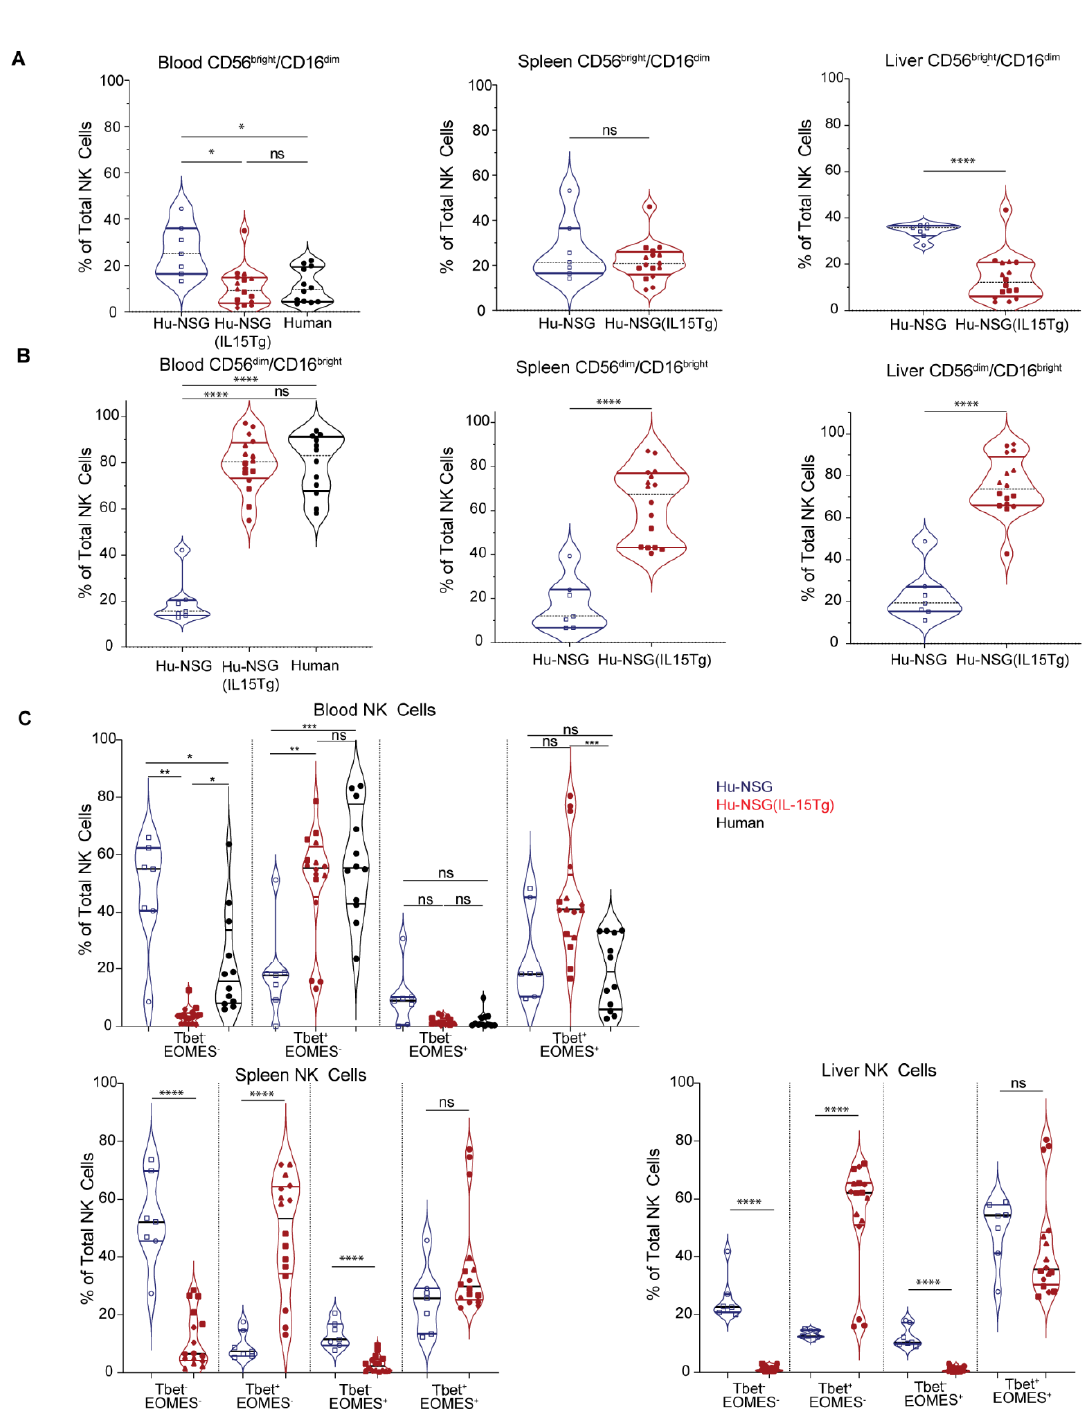
Figure 4. Phenotypically mature human NK cells are elevated in Hu-NSG-Tg(IL-15) mouse tissue. ( A ) Frequency of CD56 bright CD16 dim of NK cells in blood, liver, and spleens of Hu-NSG mice ( n = 7, 2 unrelated donors), Hu-NSG-Tg(IL-15) mice ( n = 16, 4 unrelated donors) 6 months post CD34 + HSC transplant, and human donors ( n = 12). ( B ) Frequency of CD56 dim CD16 bright subset in blood, livers, and spleens of Hu-NSG and Hu-NSG-Tg(IL-15) mice 6 months post CD34 + HSC transplant. ( C ) Tbet and EOMES expression of NK cells in blood, liver, and spleens of Hu-NSG, Hu-NSG-Tg(IL-15) mice 6 months post CD34 + HSC transplant, and human donors. Mice reconstituted from unrelated human donor cord-blood-derived CD34 + stem cells are denoted by different symbols. Statistical significance was calculated using an unpaired t-test for 2 groups or Brown–Forsythe test for 3 groups. ns = not significant,* p < 0.05, ** p < 0.01, *** p < 0.005, and **** p < 0.0001.